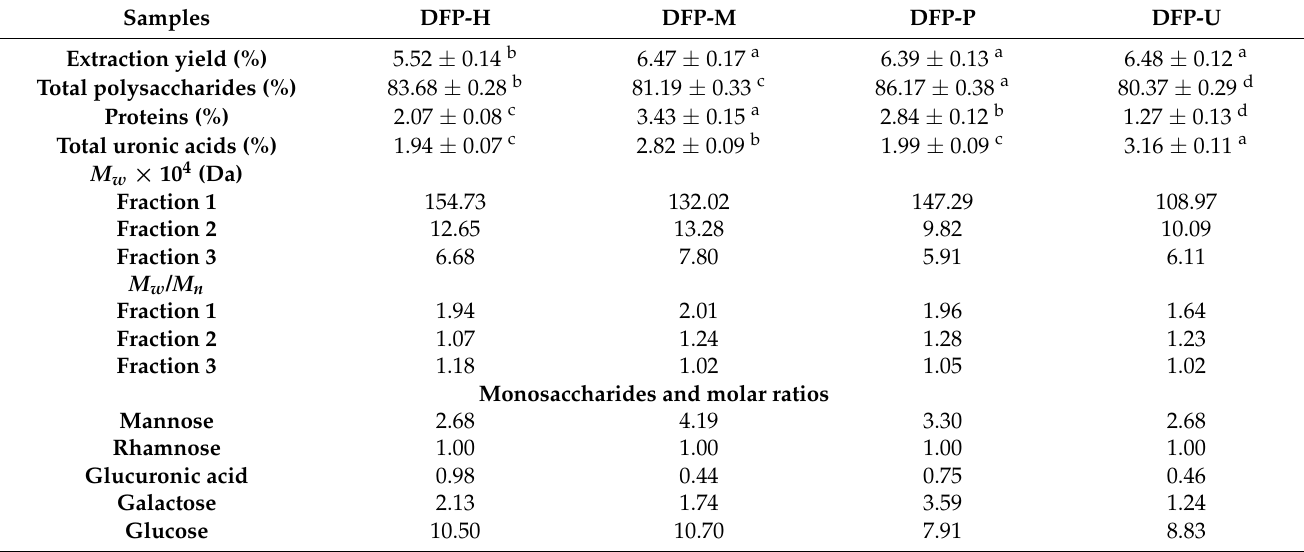
Table 1. Chemical compositions, molecular weights ( M w ), and compositional monosaccharides of DFP-H, DFP-M, DFP-U, and DFP-P.